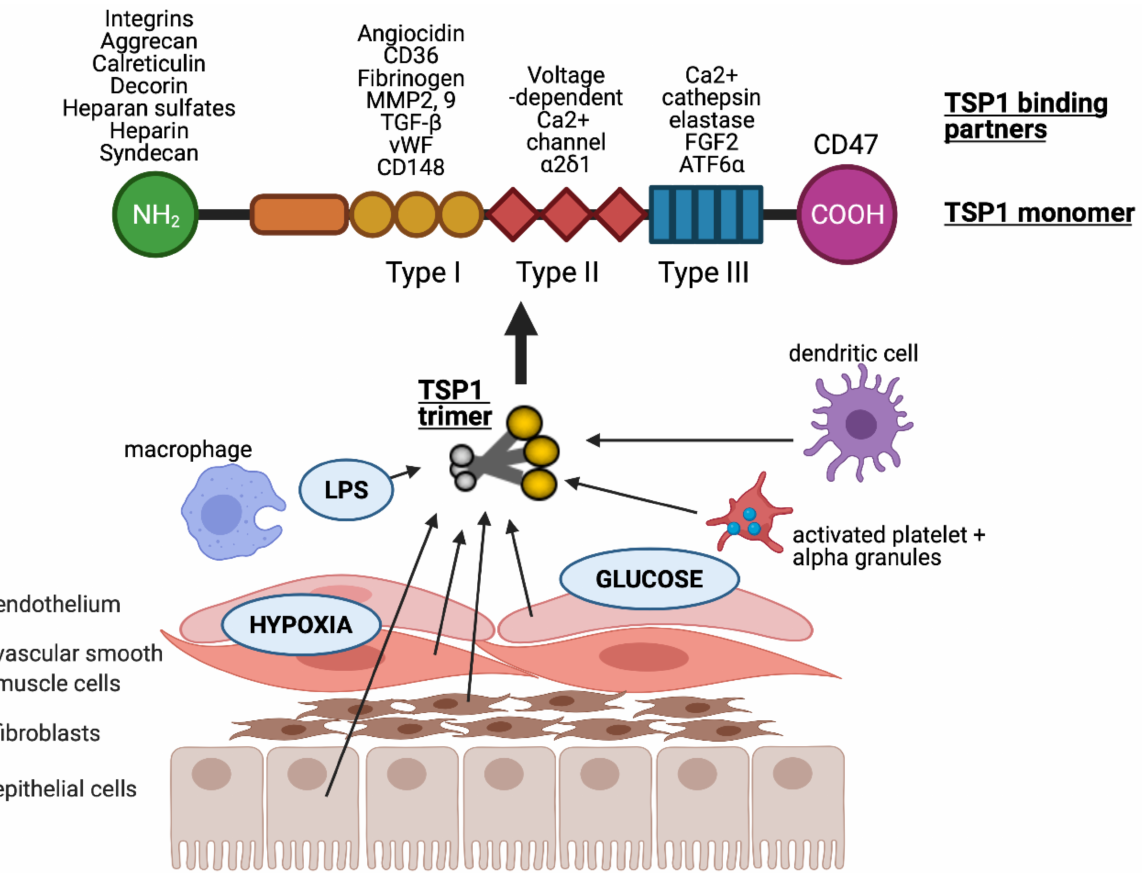
Figure 1. TSP1 is produced by many nucleated cells, including antigen presenting cells (macrophages and dendritic cells) and parenchymal cells (endothelial, vascular smooth muscle and epithelial cells, as well as fibroblasts). TSP1 is upregulated in response to injurious stimuli such as low oxygen tension (hypoxia), hyperglycaemia and lipopolysaccharide (LPS). It is typically secreted in trimeric form which is required for activity. Each monomer consists of multiple binding domains capable of interacting with a wide variety of